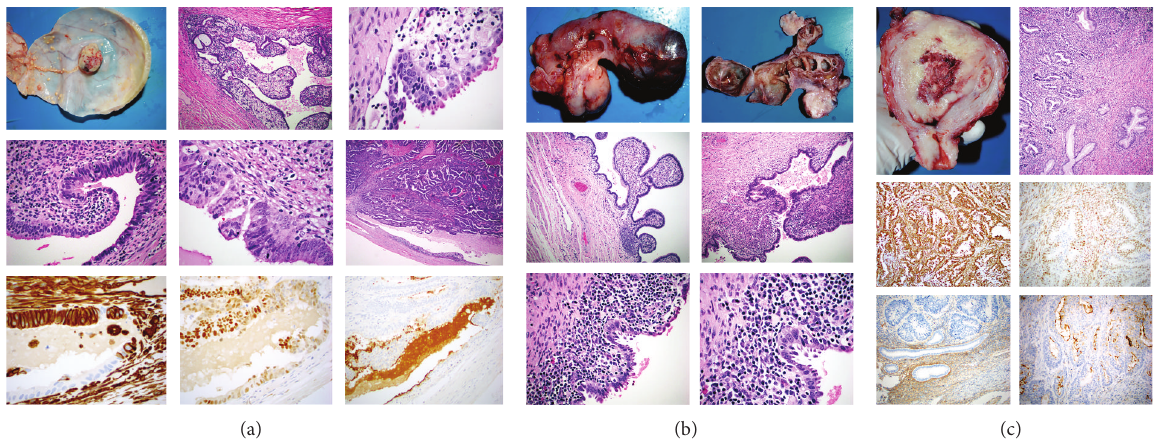
Figure 3: (a) The upper left panel is the macroscopic image of the right fallopian tube which is markedly distended and shows a polypoid mucosal mass (right tube). Small yellowish deposits are also seen in the mucosa. The upper middle and right panels show chronic xanthomatous salpingitis with lymphoid and foam cell infiltration. The middle panel is the Haematoxylin and Eosin stained section with an original magnification of × 10 and the right panel which is the also Haematoxylin and Eosin stained section with an original magnification of × 40. The left panel of the middle row shows tubal epithelium near the polypoid lesion with high grade dysplasia (Haematoxylin and Eosin stained section, original magnification × 40). The middle panel of the middle row also shows tubal epithelium near the polypoid lesion with high grade dysplasia (Haematoxylin and Eosin stained section, original magnification of × 60). The right panel of the middle row shows the polypoid mass (Haematoxylin and Eosin stained section, original magnification of × 4). The left panel of the lower row is a vimentin stain which stains the stroma and the dysplastic epithelium but not the normal tubal epithelium (immunoperoxidase stain, original magnification × 60). The middle panel of the lower row is immunoperoxidase stain for oestrogen receptor with an original magnification × 40. The dysplastic tubal epithelium is strongly positive (upper part) and normal tubal epithelium is weakly positive (lower part). The right panel of the lower row is immunoperoxidase stain for CA125 with an original magnification of × 20. The epithelium (normal and dysplastic) shows luminal staining. (b) The upper panels are macroscopic images showing a normal ovary but a distended fallopian tube (left tube). The external surface is shown in the left panel and cut surface is shown in the right panel. The tube shows multiple fibrous bands. The middle panels show features of chronic salpingitis with disorganisation of tubal mucosal folds, infiltration by inflammatory cells, fibrosis, and loss of muscle. The left panel of the middle row is the Haematoxylin and Eosin stained section with an original magnification of × 4 and the right panel of the middle row is also the Haematoxylin and Eosin stained section but at original magnification of × 10. The lower panels also show features of chronic salpingitis with focal epithelial atypia in the centre of the images. The left panel of the middle row is the Haematoxylin and Eosin stained section with an original magnification of × 40 and the right panel of the middle row is also the Haematoxylin and Eosin stained section but at original magnification of × 60. (c) The left upper panels are macroscopic images of the uterus with a somewhat polypoid endometrial lesion (uterus). The right shows an endometrioid carcinoma which is infiltrating the endocervix (Haematoxylin and Eosin stained section, original magnification of × 4). The left panel of the middle row is a vimentin stain which shows strong stromal and epithelial expression (immunoperoxidase stain, original magnification of × 10). The right panel of the middle row is immunoperoxidase stain for oestrogen receptor with an original magnification of × 20. Positive staining is observed in the stroma as well as the epithelium. The left panel of the lower row is CD10whichstainsthenormalendometrium(lowerpart)butnotthecarcinoma(immunoperoxidasestain,originalmagnificationof × 20).The right panel of the lower row is CA125 which shows luminal staining in the malignant glands (immunoperoxidase stain, original magnification of ×